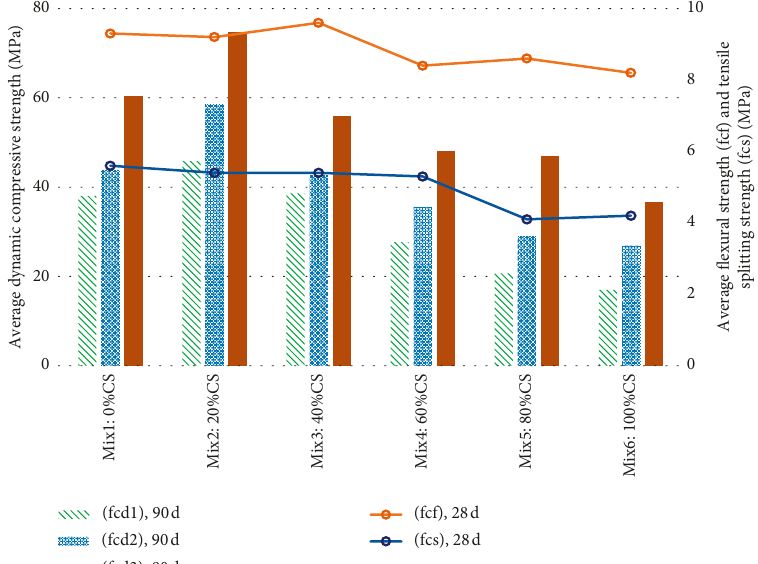
Figure 2: Dynamic compressive strength, flexural strength, and tensile splitting strength of copper slag concrete mixes (adapted from Wu et al. [31]). Note: fcf, 28d: average flexural strength, moist-cured at 28 days; fcs, 28 d: average tensile splitting strength, moist-cured at 28 days; fcd1, 90d: average dynamic compressive strength at a strain rate of ∼ 100s − 1 , at 90 days curing age; fcd2, 90d: average dynamic compressive strength at a strain rate of ∼ 200s − 1 , at 90 days curing age; fcd3, 90d: average dynamic compressive strength at a strain rate of ∼ 300s − 1 , at 90 days curing age.